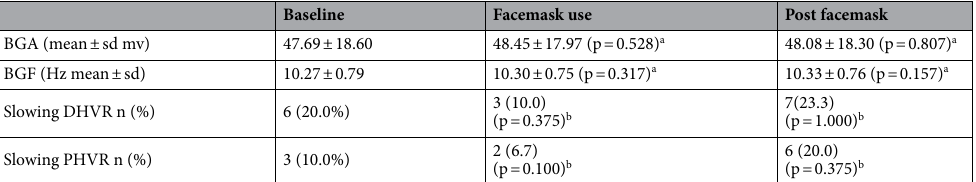
Table 3. Electroencephalographic(EEG) findings in the three phases of the study (n = 30). BGF, background frequency; BGA background amplitude; DHVR during hyperventilation response; PHVR post hyperventilation response. a Wilcoxon test compared with baseline. b Cochran’s Q test. baseline, FM use and